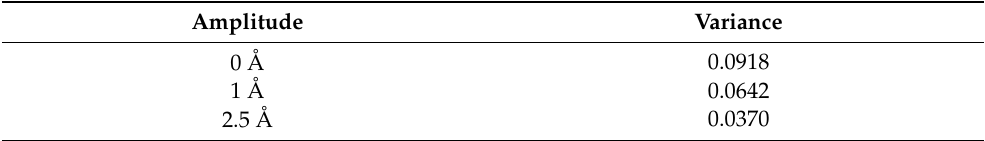
Table 8. Variances of concentration with different